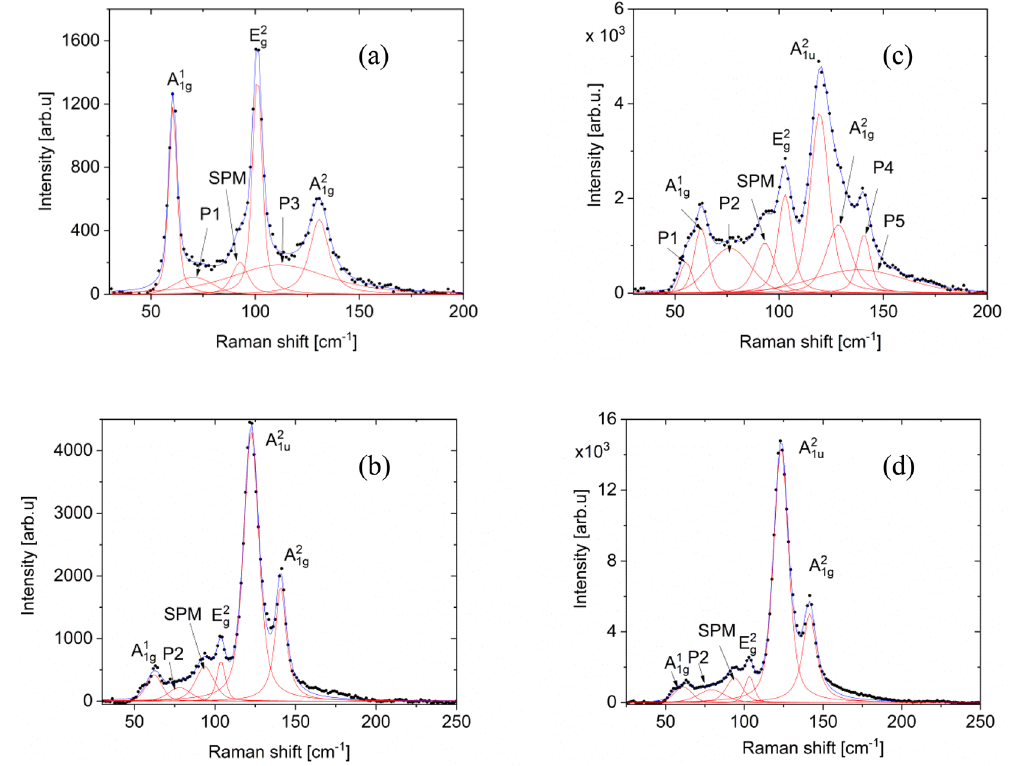
Figure 2. Micro-Raman spectra of Bi 2 Te 3 on semiconducting ( a ) Si and ( b ) GaAs substrates; TERS spectra of Bi 2 Te 3 on semiconducting ( c ) Si and ( d ) GaAs substrates. Modes P3 and P4 are related to small stoichiometry variations within the area probed by the laser spot. Mode P5 is usually observed only in Raman spectra of 1–2 QL thick layers 11